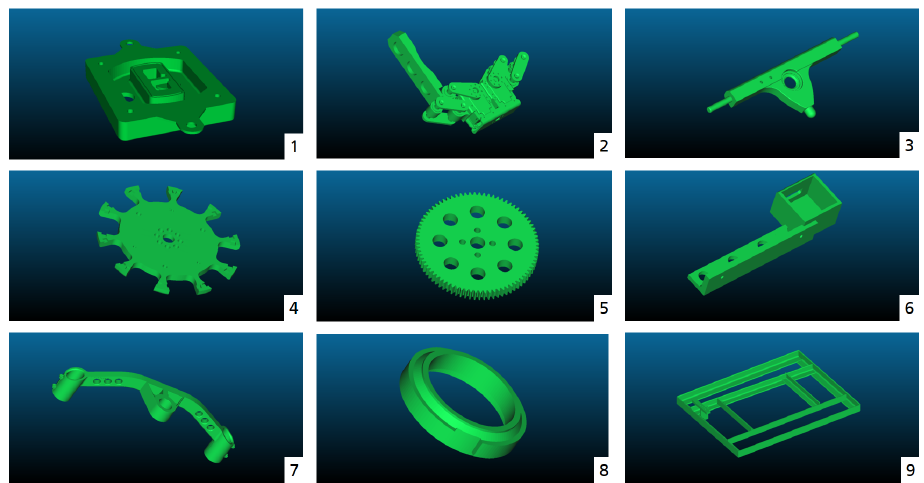
Figure 6. An illustration of the test workpieces used in our experiments. Each of them is part of the ABC Dataset [22], except for the custom workpiece number